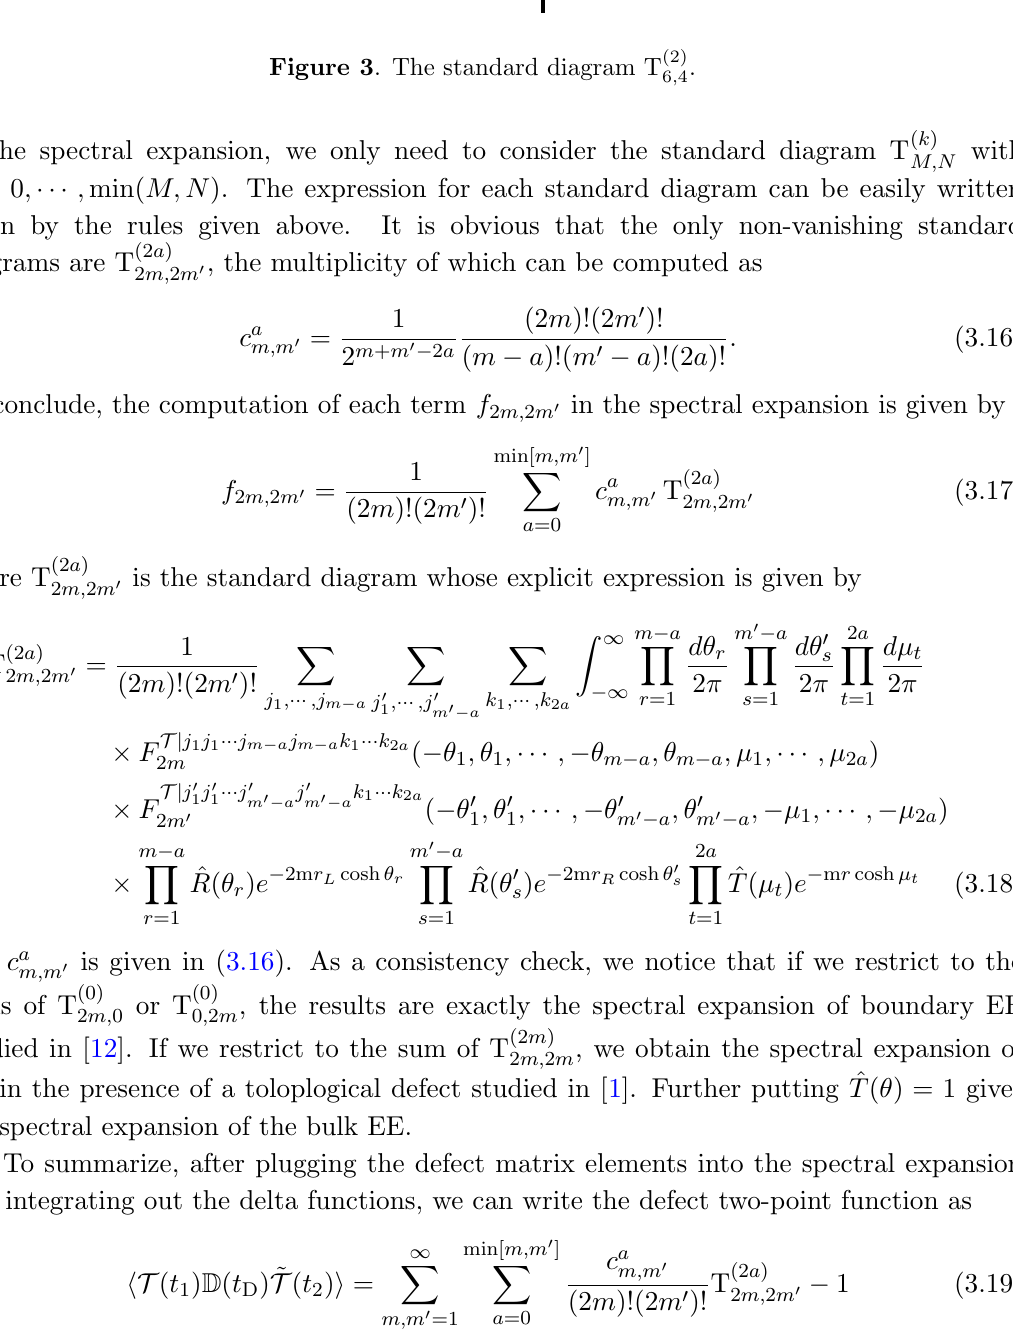
Figure 3 . The standard diagram T (2)